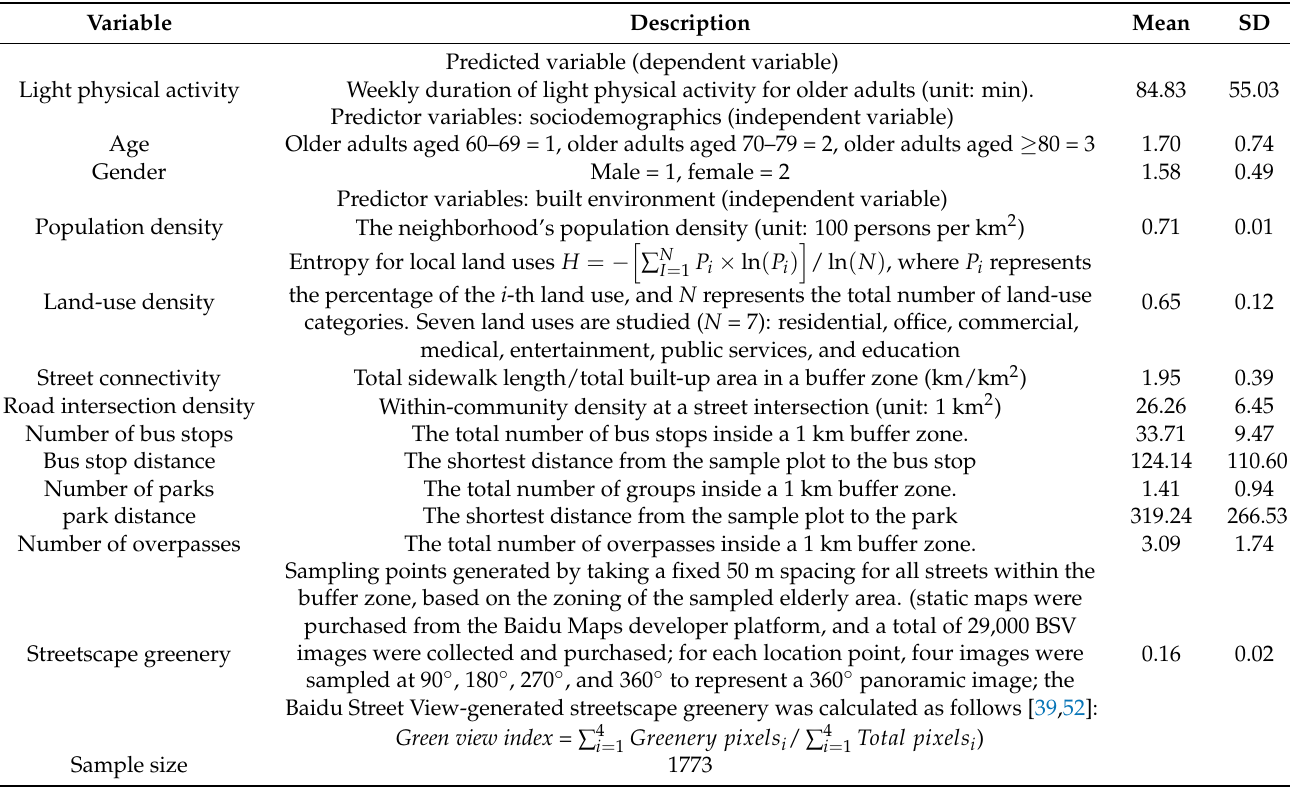
Table 2. Descriptiveon and summary statistics of the predicted and predictor